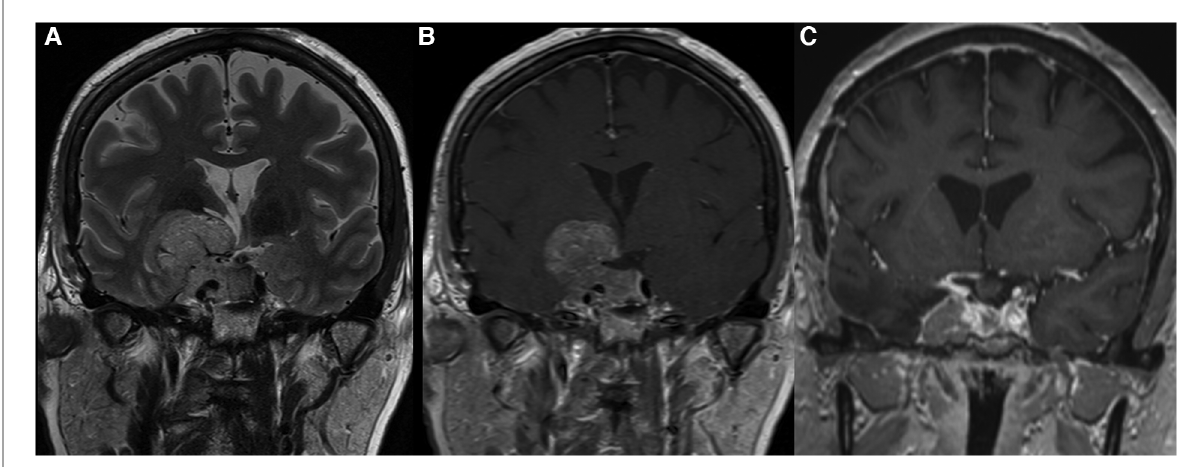
FIGURE 5 A giant macroadenoma showed invasion of the right cavernous sinus (Knosp 4), and it was classi fi ed as grade 4 according to the relationship with the diaphragm (Pictures A and B showing a coronal T2- and T1-weighted MRI after gadolinium administration, respectively). A combined approach through the use of a pterional approach and an endoscopic endonasal approach allowed to obtain a partial resection after addressing respectively the portion in the subarachnoid space and the sellar and suprasellar portion. The residual tumor in the right cavernous sinus (Picture C) was treated through Gamma Knife irradiation, and the tumor remained stable at 5 years of